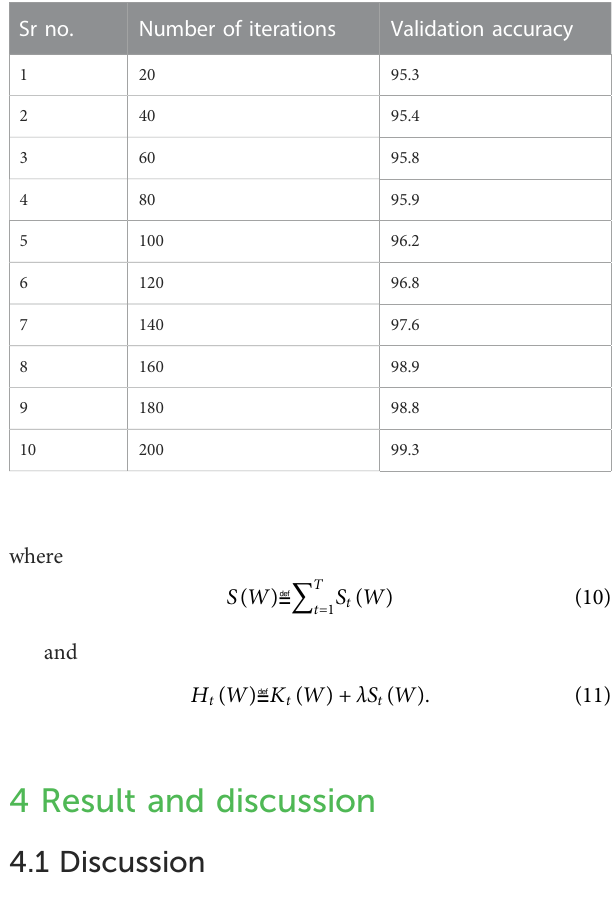
TABLE 3 Training accuracy for the proposed algorithms. Sr no.